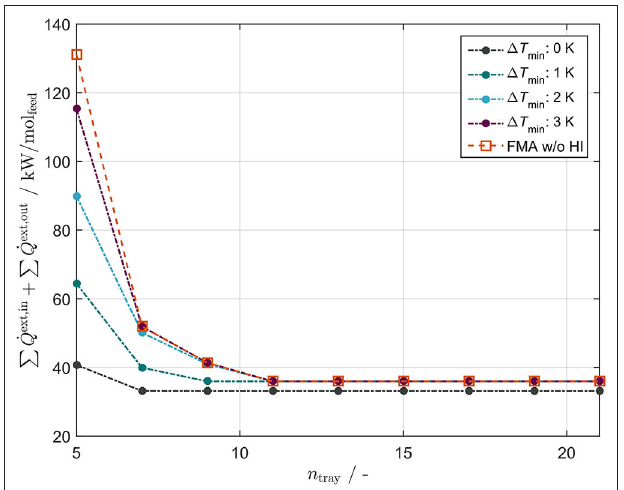
FIGURE 10 | Influence of the selected minimum temperature difference 1 T min of the additional heat transfer. Illustrated are the heat integrated results for 1 T min = 0,1,2,3 K as well as the non-integrated result as a benchmark for discretization of 17 temperature stages.